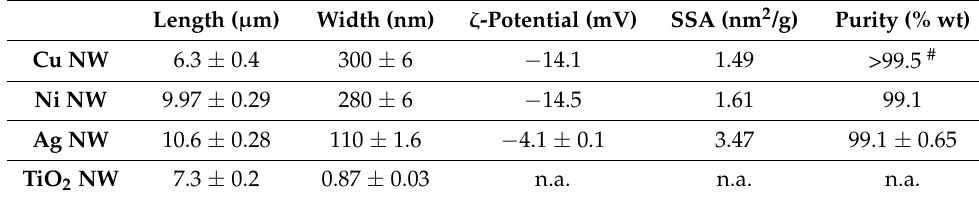
Table 3. Summarized physicochemical properties of the investigated nanowire. Length and width have been determined by scanning electron microscopy, SSA: specific surface